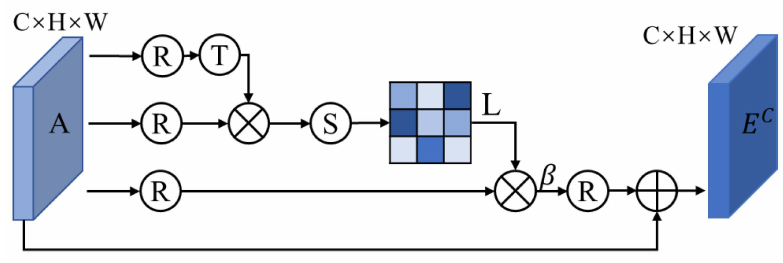
Figure 7. Channel attention